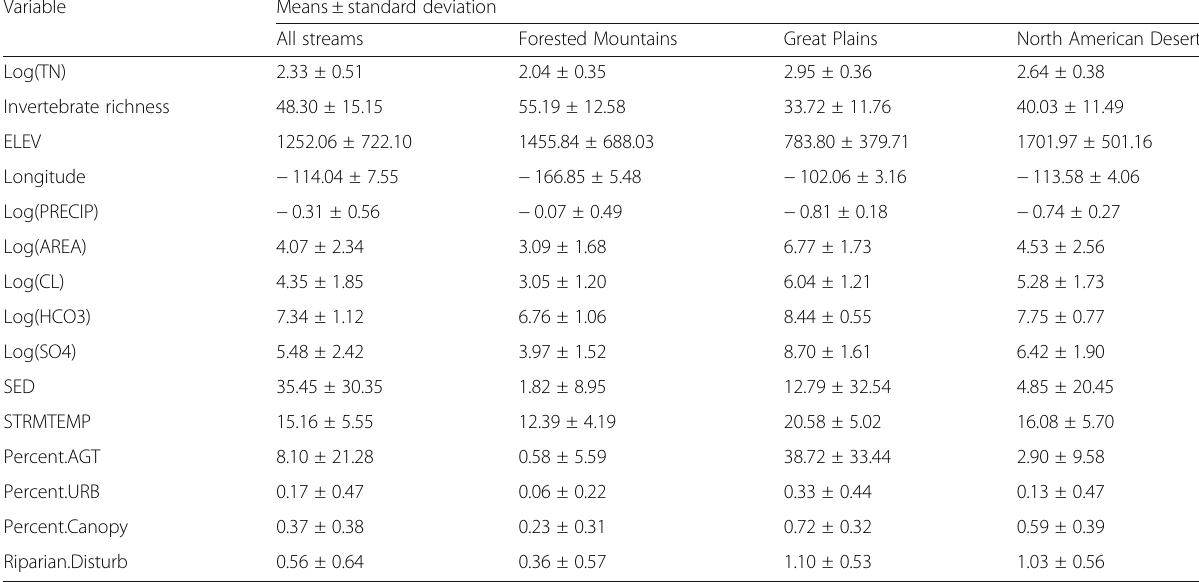
Table 2 The mean and standard deviation of all confounding factors, the treatment log TN, and the response invertebrate richness within all streams and within the three strata